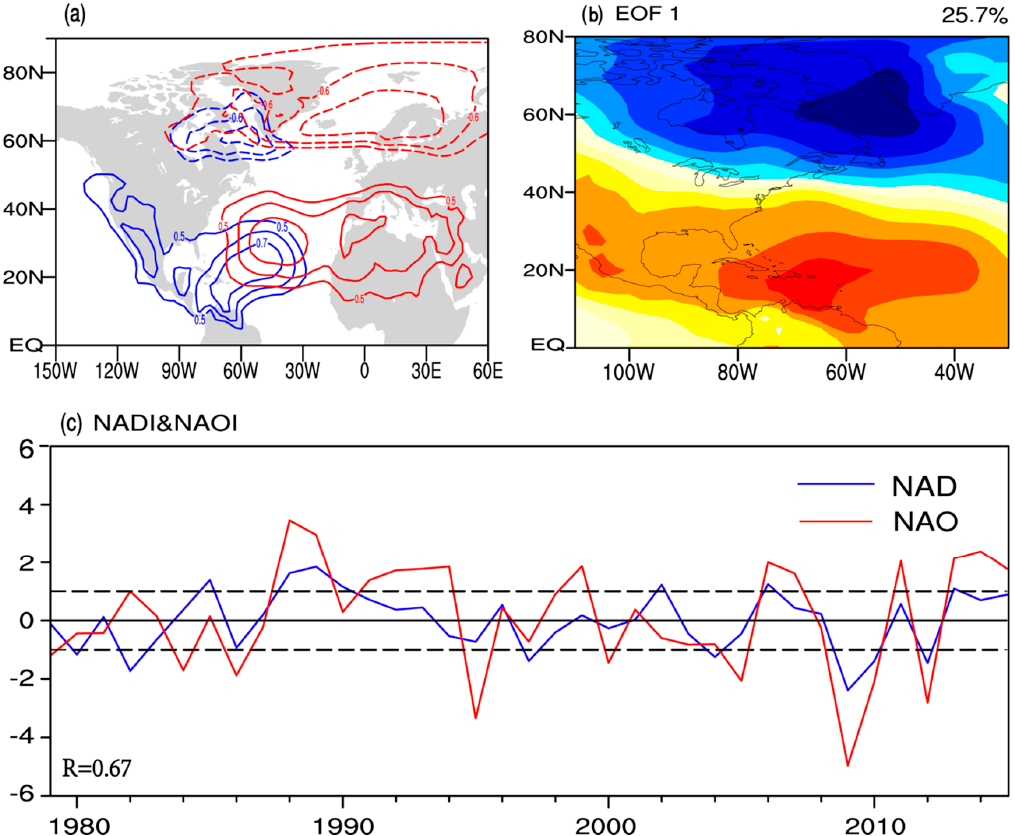
Figure 2. ( a ) Maps of correlation between the DJFM-averaged SLP anomalies and the simultaneous NADI (blue lines) and NAOI (red lines). The contour interval is 0.1. Only correlations greater than 0.5 are shown; ( b ) spatial pattern of the first leading EOF mode from North America to the North Atlantic (110–30° W, 0–80° N); ( c ) time series of the DJFM-averaged NADI (blue line) and NAOI (red line). The horizontal dashed lines indicate ±1 standard deviation. The correlation coefficient ( R ) between the NADI and NAOI is shown in the lower left corner.